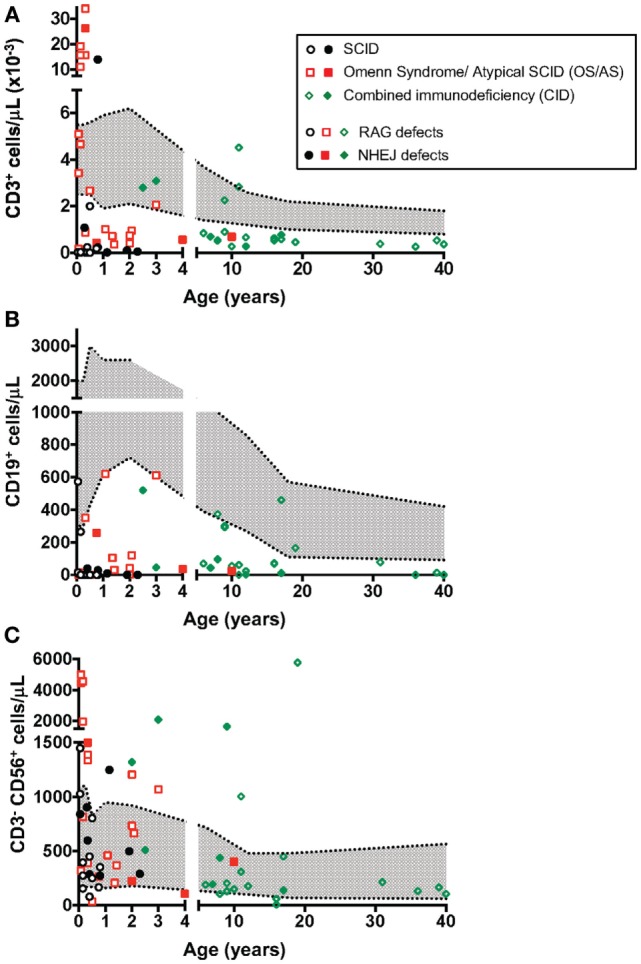
Absolute count of T (A), B (B), and natural killer (NK) (C) lymphocytes at the time of evaluation of NK cell phenotype and function. The area shown in shaded gray represents normal values for age. Different symbols (circle, square, diamond) are used to indicate patients with severe combined immune deficiency (SCID), Omenn syndrome/atypical SCID (OS/AS), and delayed onset combined immune deficiency (CID), respectively. Open circles identify patients with mutations of the recombinase-activating gene (RAG), and close symbols identify patients with mutations in genes involved in non-homologous end joining (NHEJ).